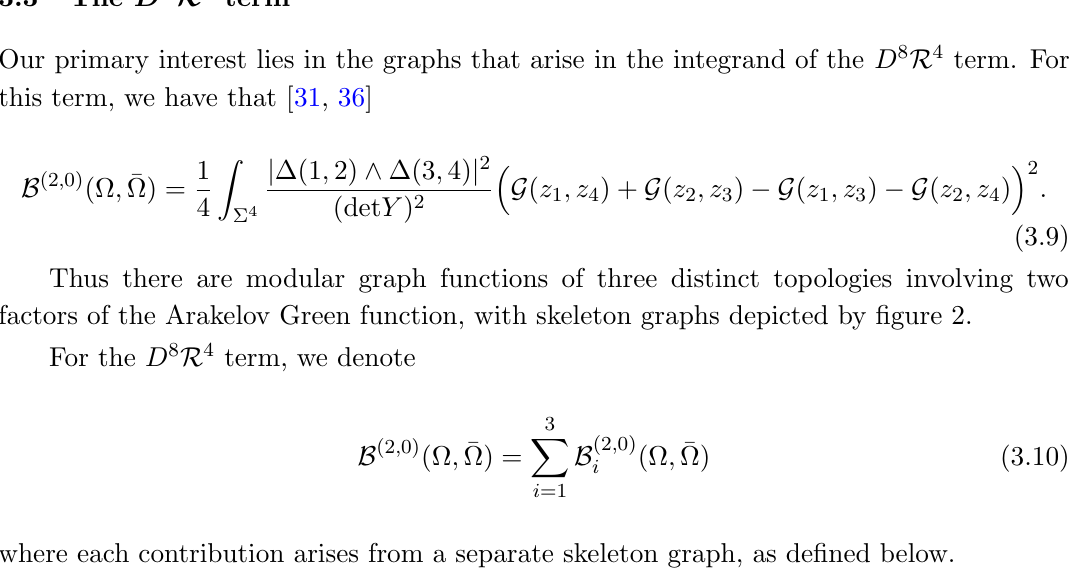
Figure 2 . Skeleton graphs for the D 8 R 4